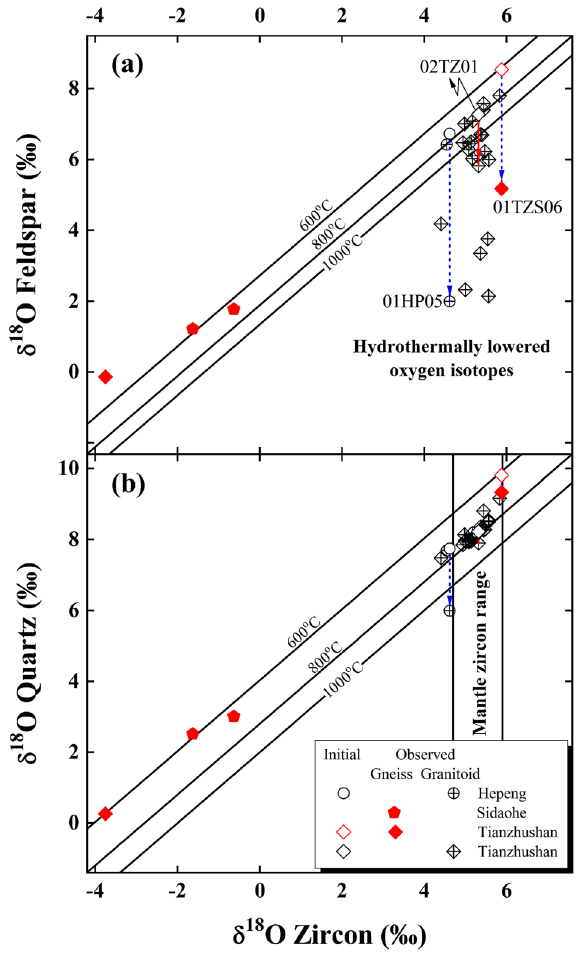
Figure 2. Diagrams of zircon vs. alkali feldspar ( a ) and quartz δ 18 O values ( b ) for the granitoids and gneisses from the Dabie orogen. Lines labelled with temperatures are isotherms after Ref. 21 , and two vertical solid lines in ( b ) denote the variability of mantle zircon δ 18 O values (5.3 ± 0.6‰) for comparison 22 . Arrowed lines